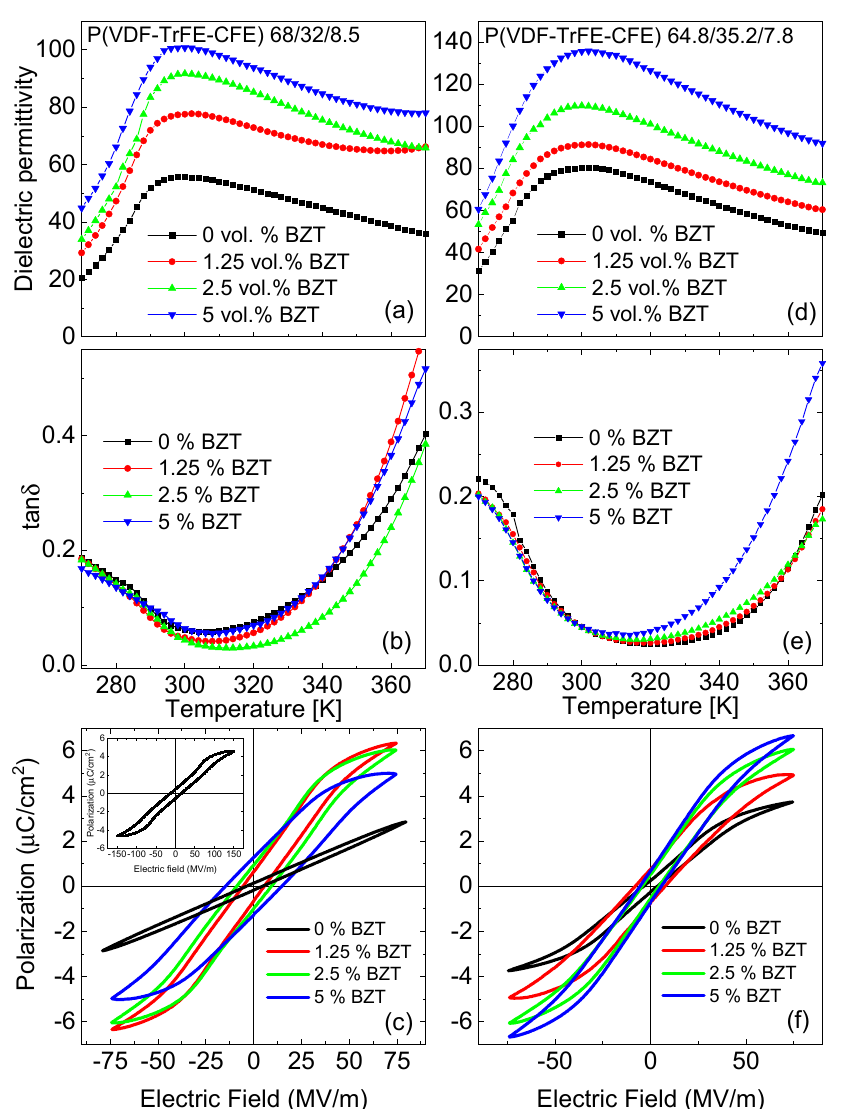
Figure 2. Temperature dependences of the real part of dielectric permittivity ( a , d ), and dielectric loss tangent ( b , e ) measured at a frequency of 1 kHz, and bipolar polarization hysteresis loops at room temperature ( c – f ) for composites based on P(VDF-TrFE-CFE) 68/32/8.5 ( a – c ), and P(VDF-TrFE-CFE) 64.8/35.2/7.8 ( d – f ) terpolymers.